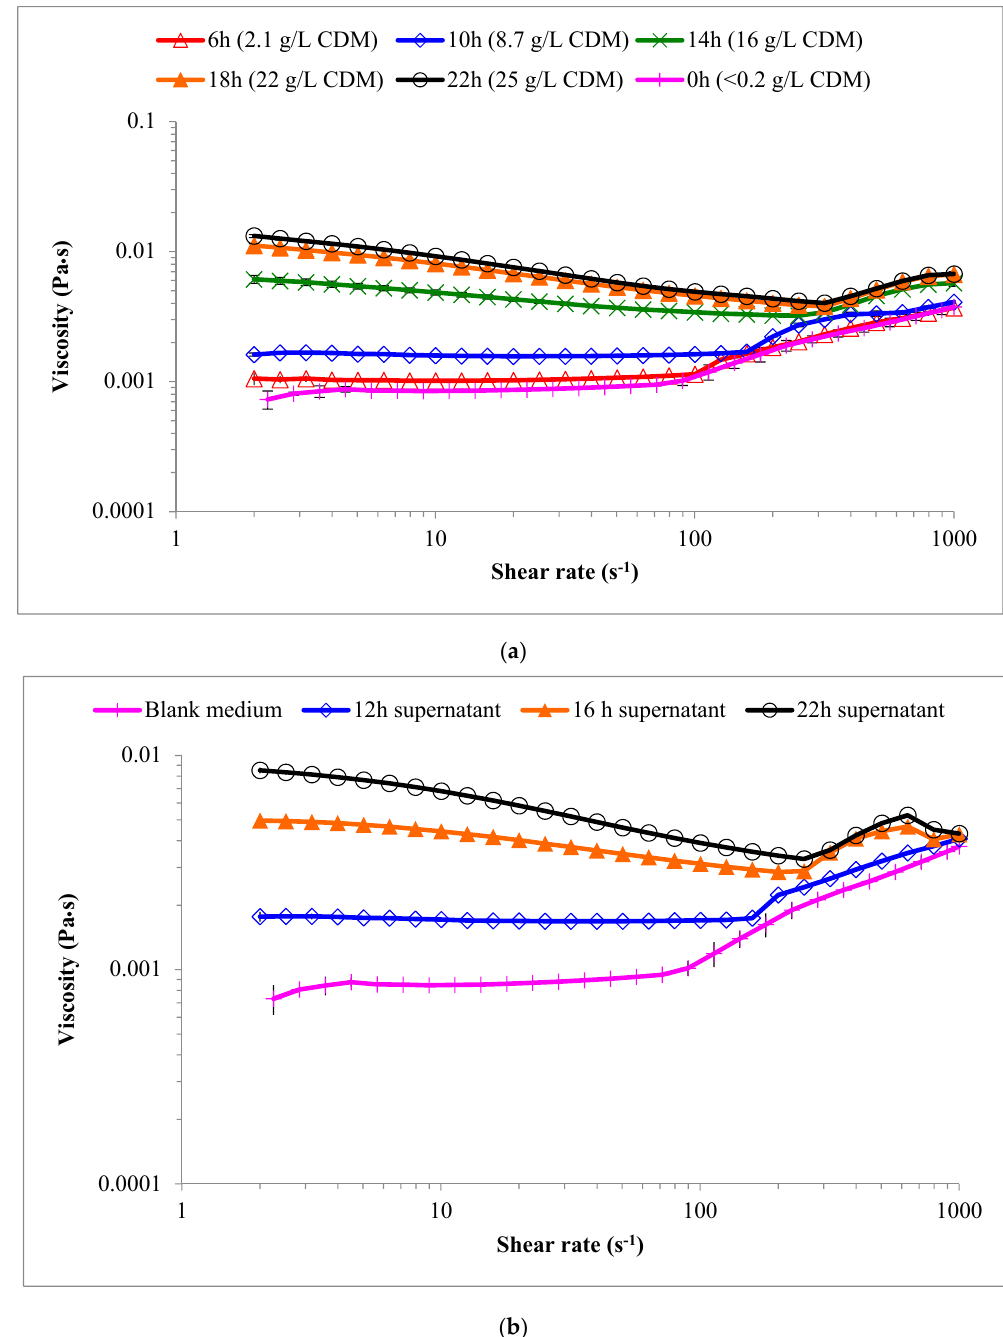
Figure 2. Flow sweep curves for samples of P. putida LS46 cultures obtained from the pilot-scale reactor. ( a ) Viscosity as a function of shear rate for 0–25 g·L − 1 cell suspensions at various points in time and ( b ) viscosity as a function of shear rate for supernatant samples at various points in time. Error bars represent standard deviations of triplicate measurements for each sample.